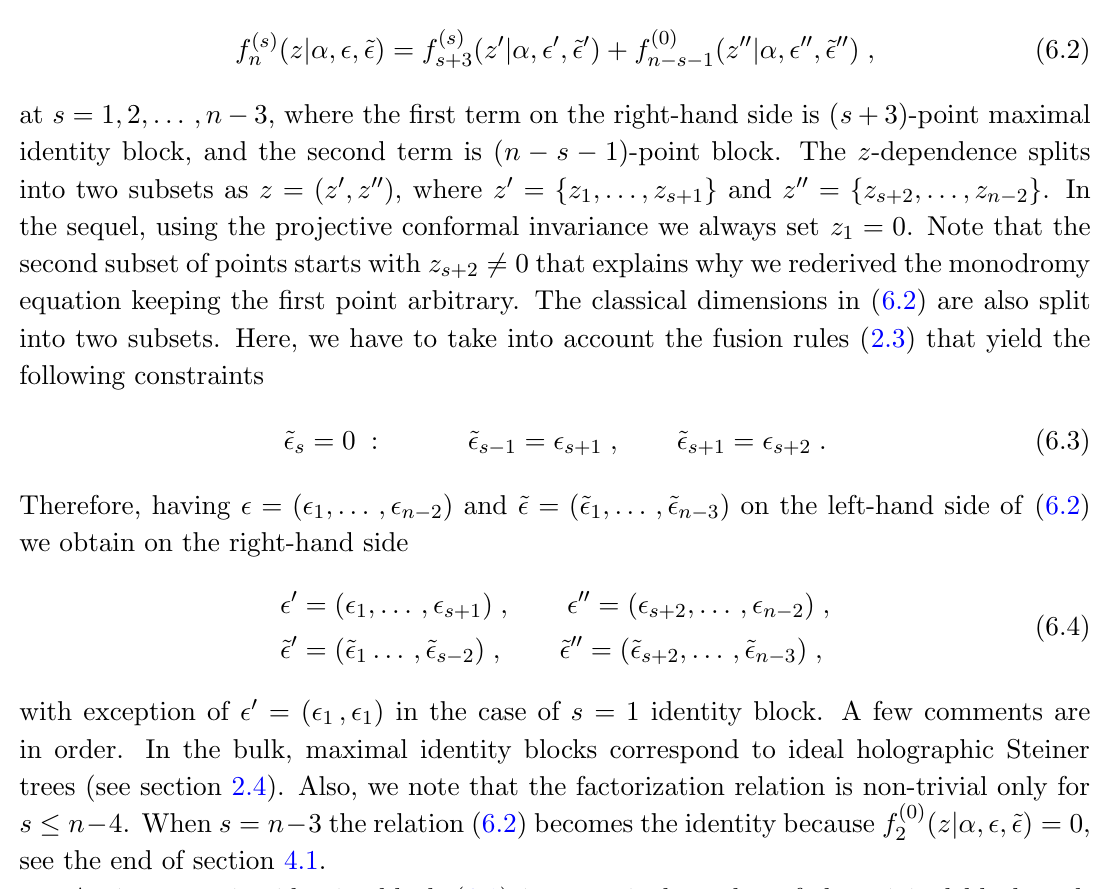
Figure 8 . Factorized 7-point block.